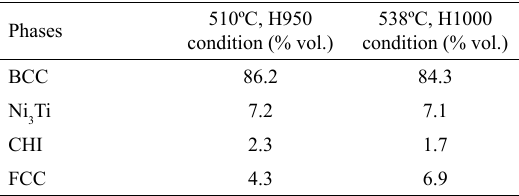
Table 5. Phases determined by Thermo-Calc (TCFE8